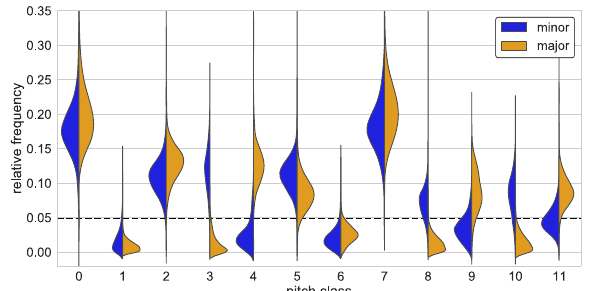
Fig. 8 Violin plot of pitch-class distributions of major and minor, summed over the Baroque and the Classical period. The classi fi cation was performed by the Bayesian mode classi fi er. Each half violin shows a Gaussian kernel density estimate of the distribution over the respective pitch-class probabilities. For each pitch class, the areas of the two respective violin halves are equal. The maxima of all violins are scaled to a common size. The dotted line at the relative frequency of 5% was added post hoc to separate in-scale tones (density maximum above the line) from out-of-scale tones (density maximum below the